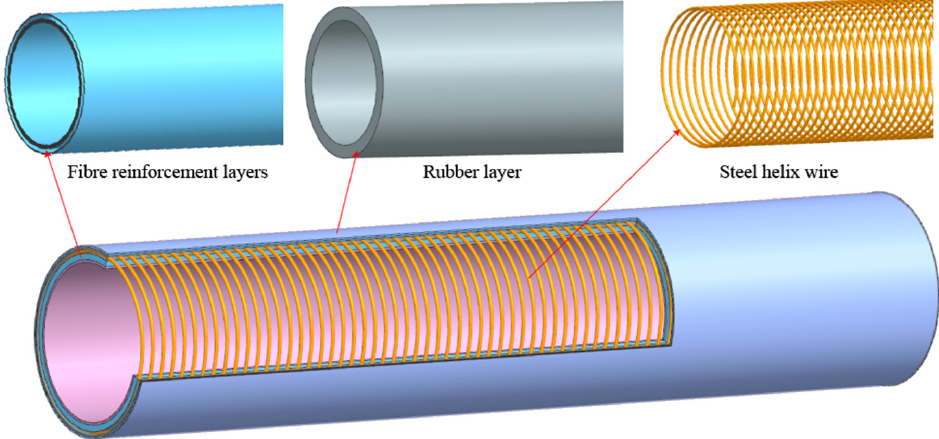
Figure 3. Simple geometric model of submarine hose.